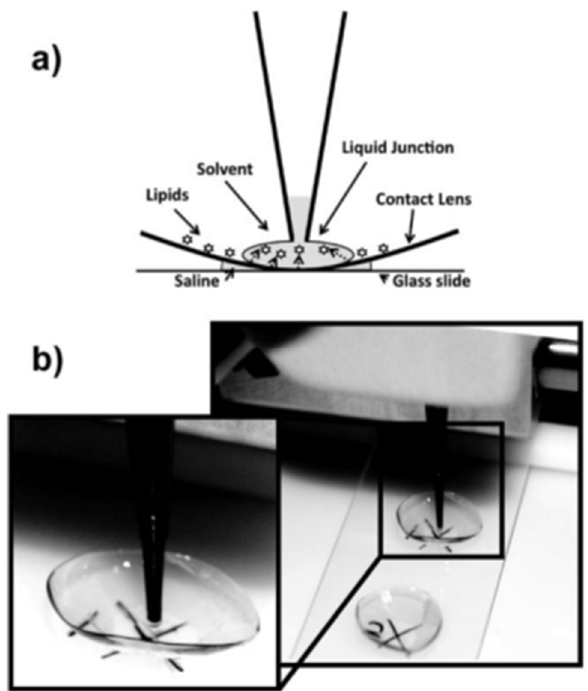
Figure 8. ( a ) Scheme of LESA extraction process on contact lenses; ( b ) Picture taken during extraction. (Reprinted from [33] with permission of the Royal Society of Chemistry of Public Analysts.)